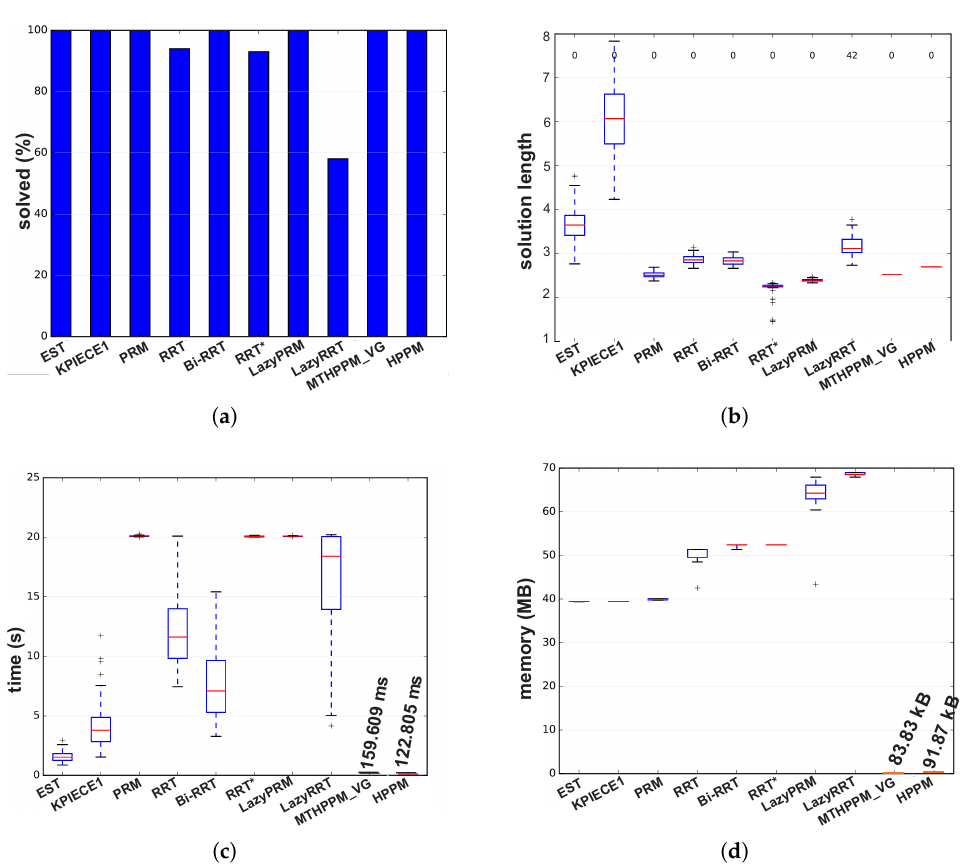
Figure 22. Comparative results for case study 3. ( a ) Successful paths. ( b ) Path length. ( c ) Execution time. ( d )